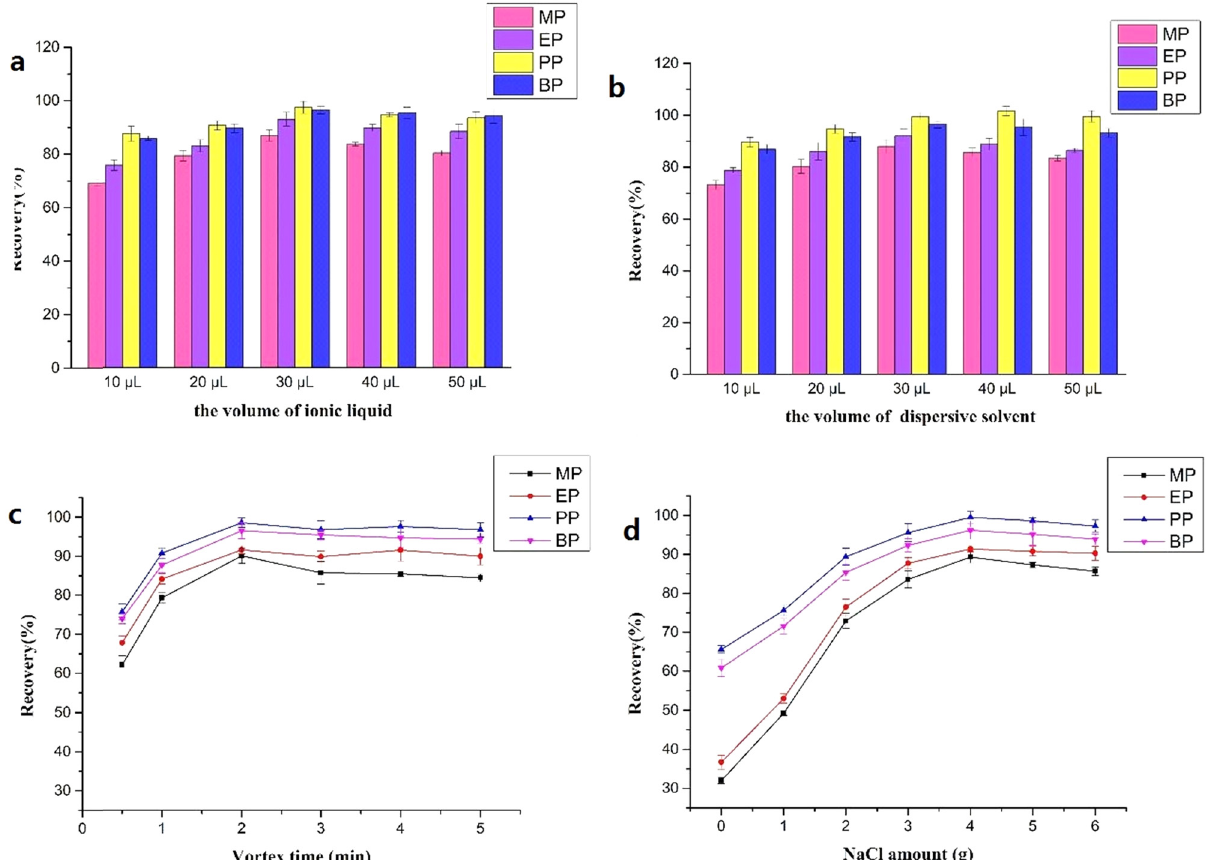
Figure 4: Optimization of extraction parameters for IL - DLLME including ( a ) volume of ionic liquid, ( b ) volume of disperser solvent, ( c ) time of vortex, and ( d ) amount of NaCl. In each optimization, the optimal amount of the previous step was used. Other conditions were considered unchanged and the same as the previous